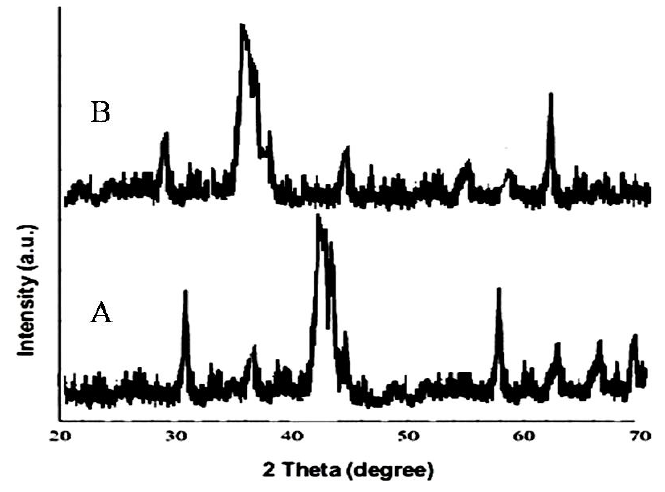
Fig. 2. XRD pattern of (A) MNPs, (B) Si-Im-HSO